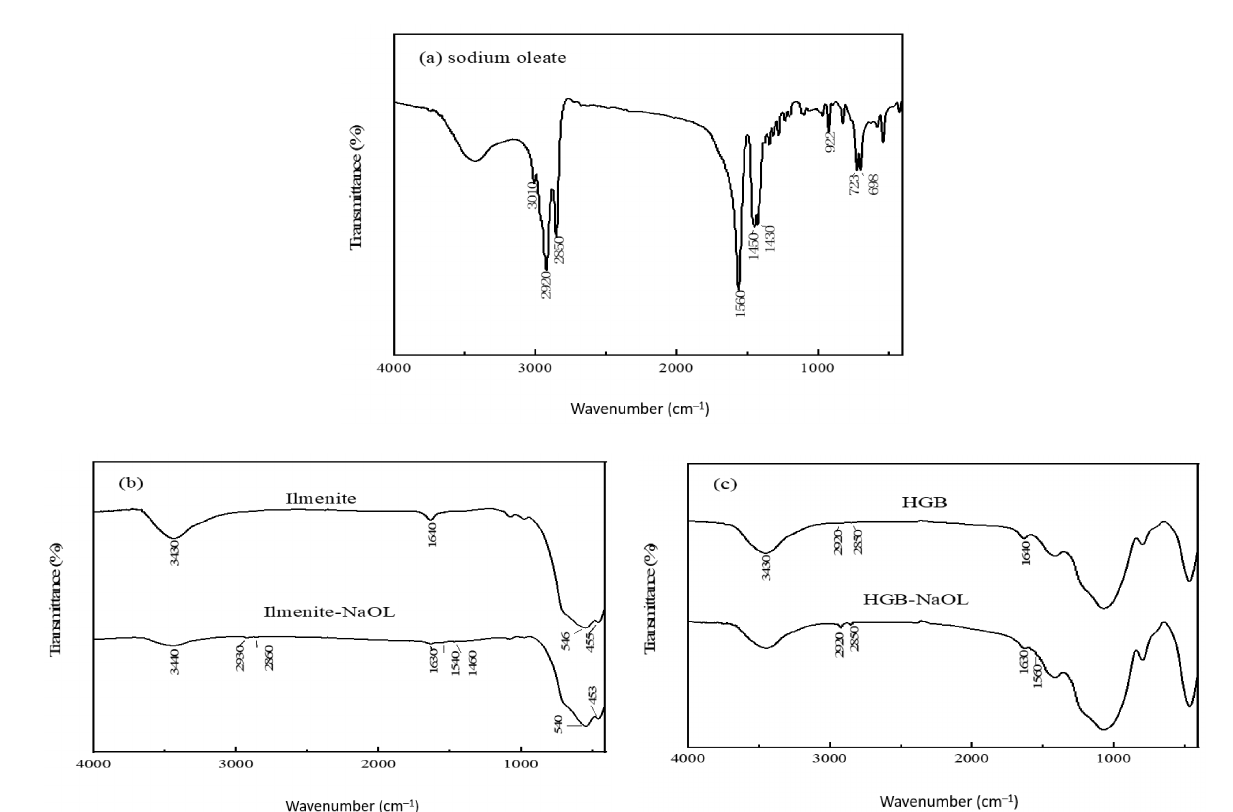
Figure 8. FTIR spectra of ( a ) NaOL, ( b ) ilmenite, and ( c ) HGB under various conditions.